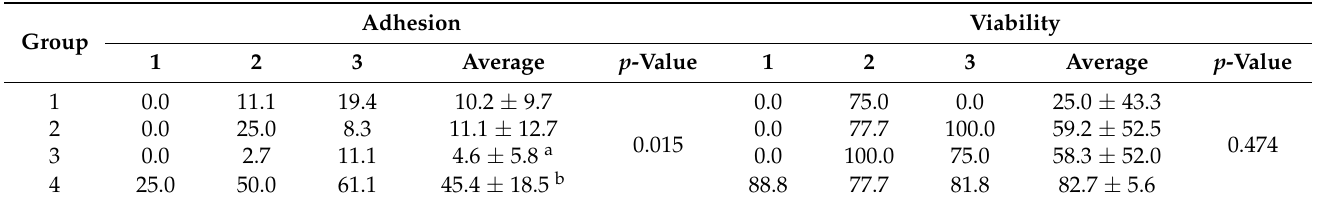
Table 2. Cell viability and adhesion measured for the four experimental groups ( n = 3).